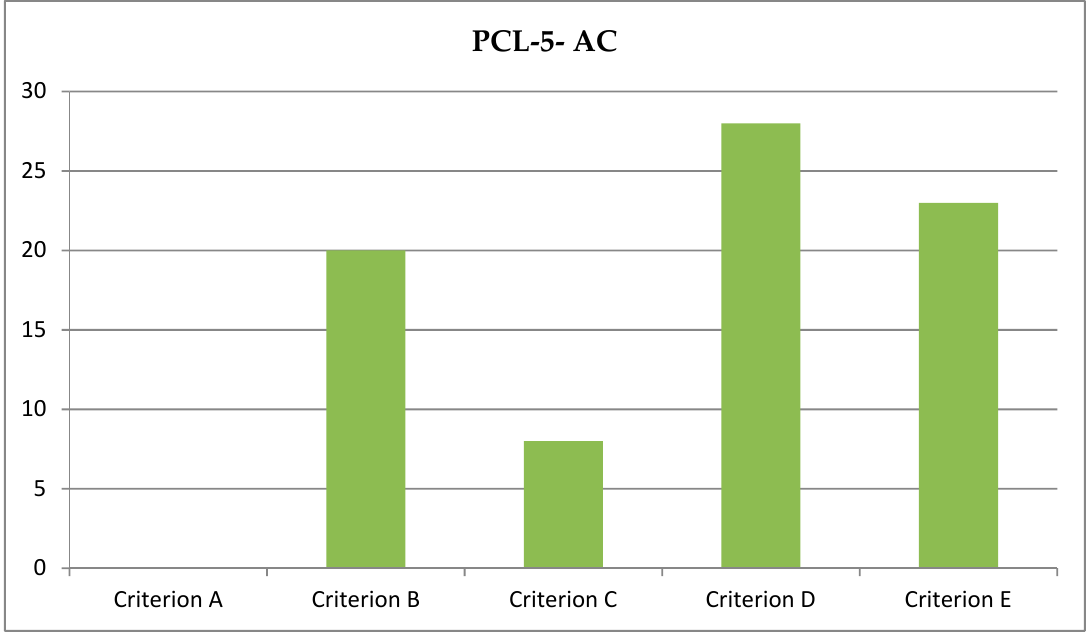
Figure 1. Previoustraumatic events and PCL-5 score .